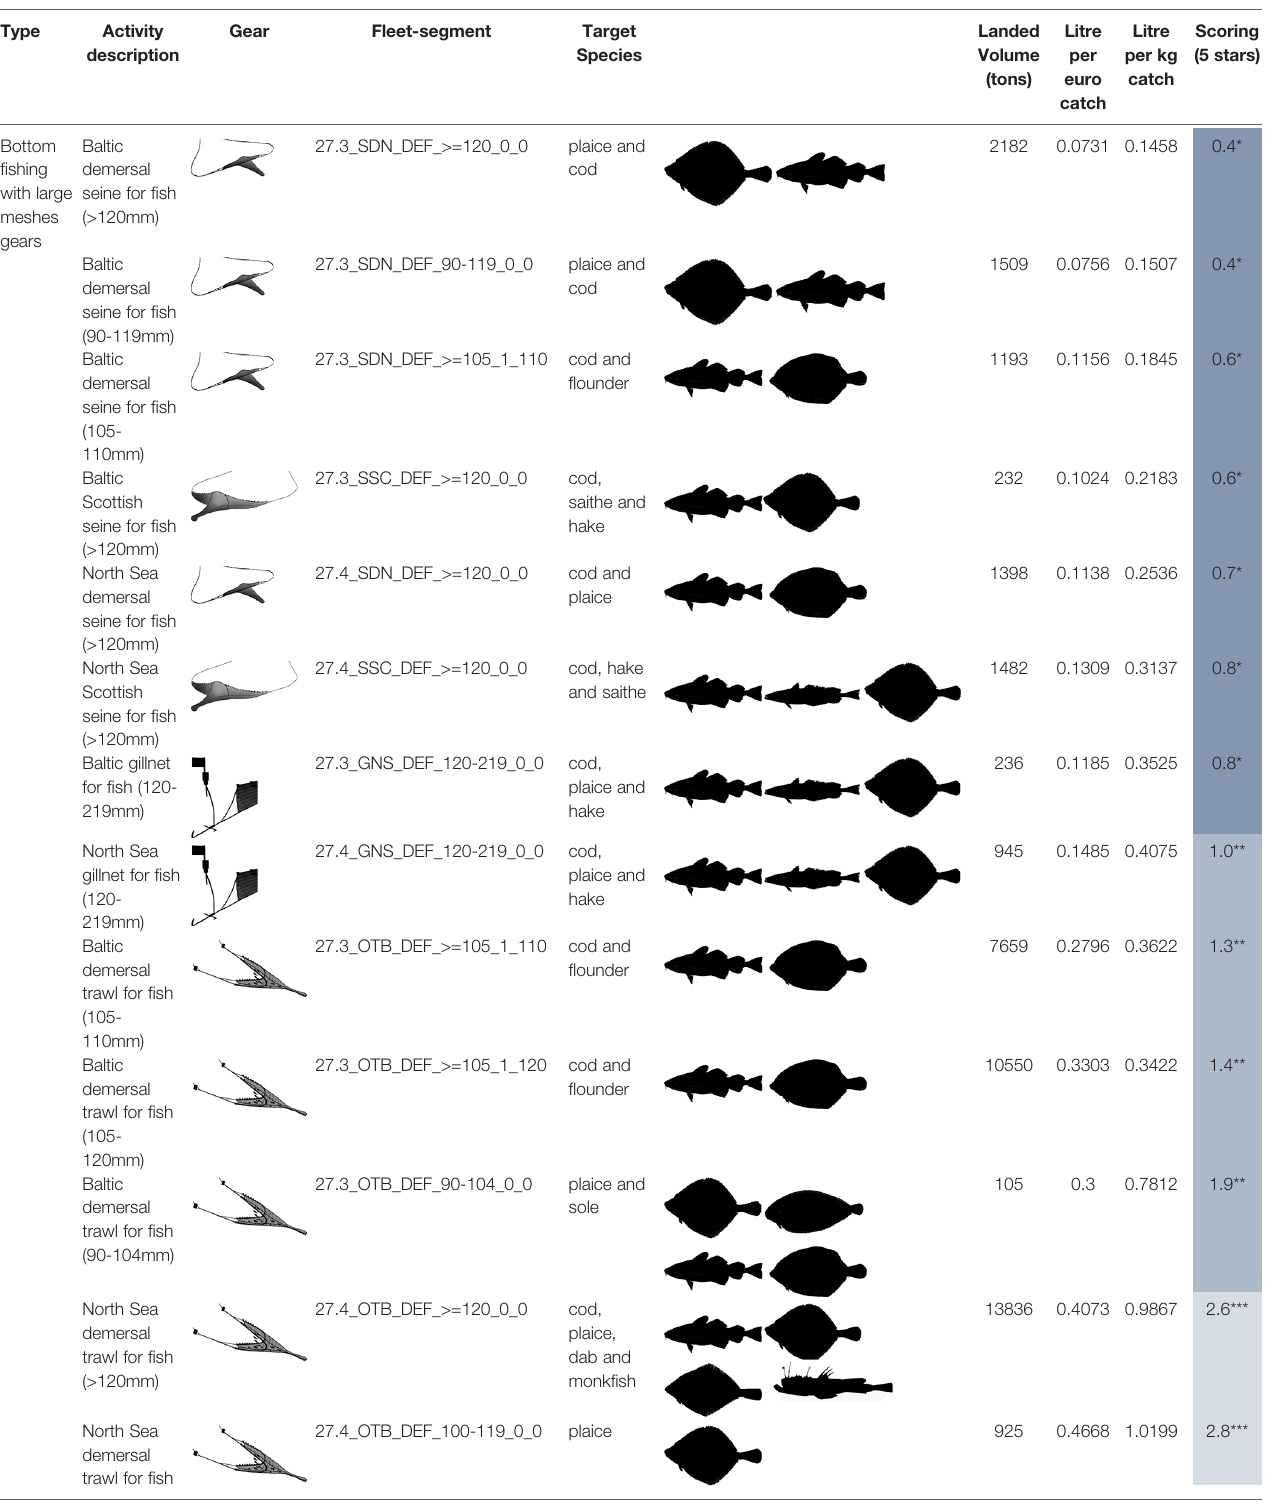
TABLE 1 | Scoring Danish segments (relative average energy consumption in the period 2005 to 2019 is assessed as the average of per liter of diesel consumed per landing value and per kg landed per fi shing trip after conversion of the two columns to percentage and expressed by stars on a scale from 1 to 5 (1-20 = ‘ * ’ , 21-40